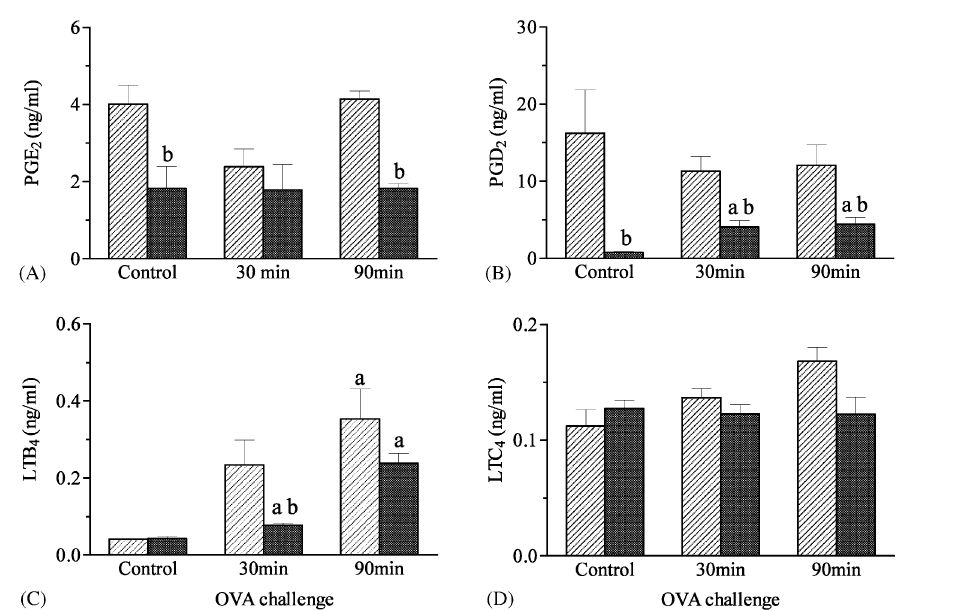
FIG. 5. Eicosanoid levels in supernatant from proximal (hatched bars) and distal (solid bars) tracheal segments after OVA challenge. Tracheal segments were isolated and placed in 24-well plates containing RMPI 1640 culture medium. After the indicated time intervals, samples (100 m l) were recovered and PGE 2 (A), PGD 2 (B), LTB 4 (C) AND LTC 4 (D) were measured by enzyme immunoassay. Control groups consisted of tracheal segments from non-challenged tissues. Data represent mean 9 / standard error of the mean from five separate experiments. Symbols over bars indicate significant differences: a, p B / 0.05 in relation to the respective control; b, p B / 0.05 in relation to the proximal